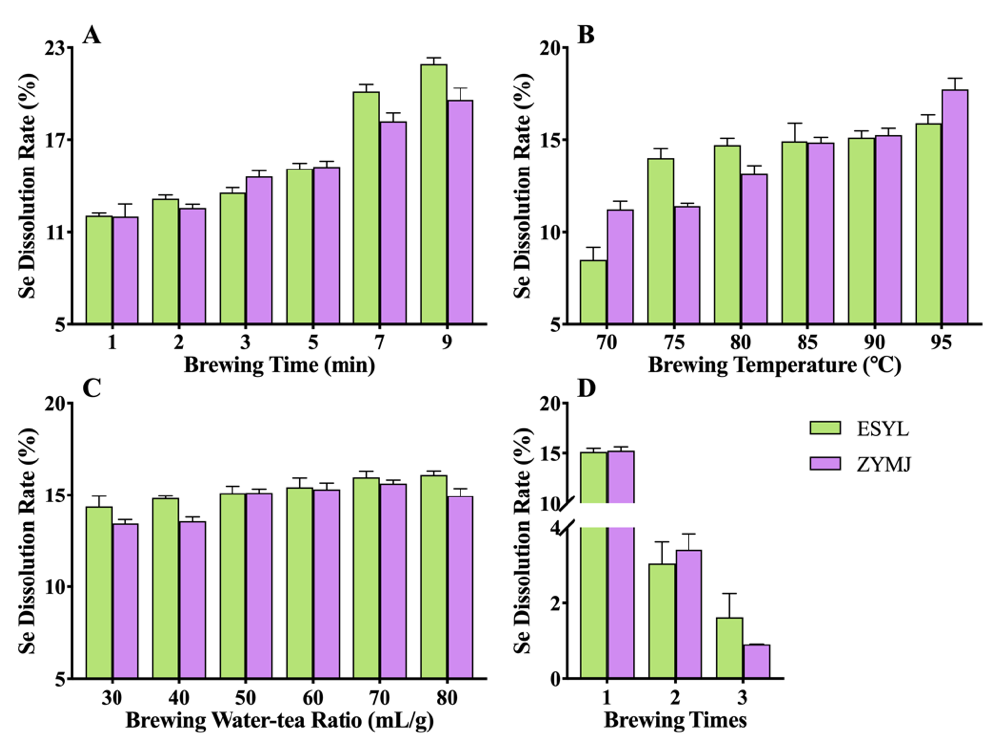
Figure 2. Effects of brewing conditions (brewing time ( A ), brewing temperature ( B ), brewing water- tea ratio ( C ), and brewing times ( D )) on Se leaching from Se-GT leaves (ESYL and ZYMJ). Data are presented as mean ± SD of the triplicate experiments.